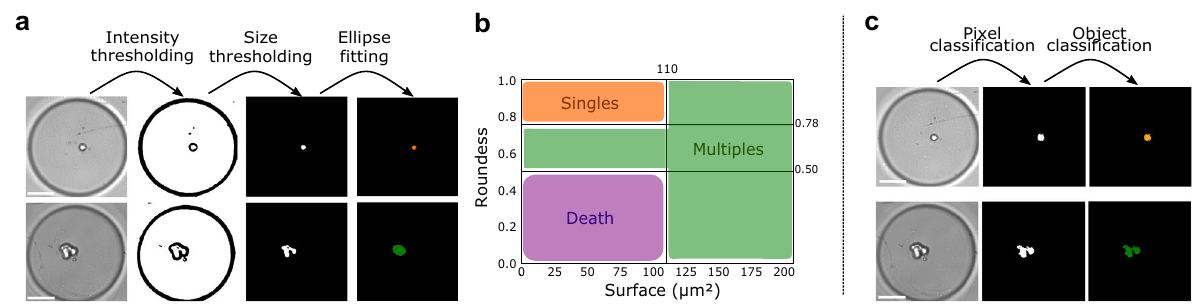
Figure 2. Working principles of the CCVA and SLBA tested in this study. ( a ) For the CCVA, images were processed through an intensity threshold before a size filtering. Remaining objects were fit to an ellipse. First row: processing of a well containing a single cell, second row: processing of a well containing multiple cells. ( b ) According to the area and roundness of the ellipse, images were classified as “Singles”, “Multiples”, “Death” or “Empty”. ( c ) For the SLBA, the first step of pixel classification segments cells from the background. Then, thanks to an object classification tool (Ilastik 27 ), images were classified between “Singles”, “Multiples”, “Death”